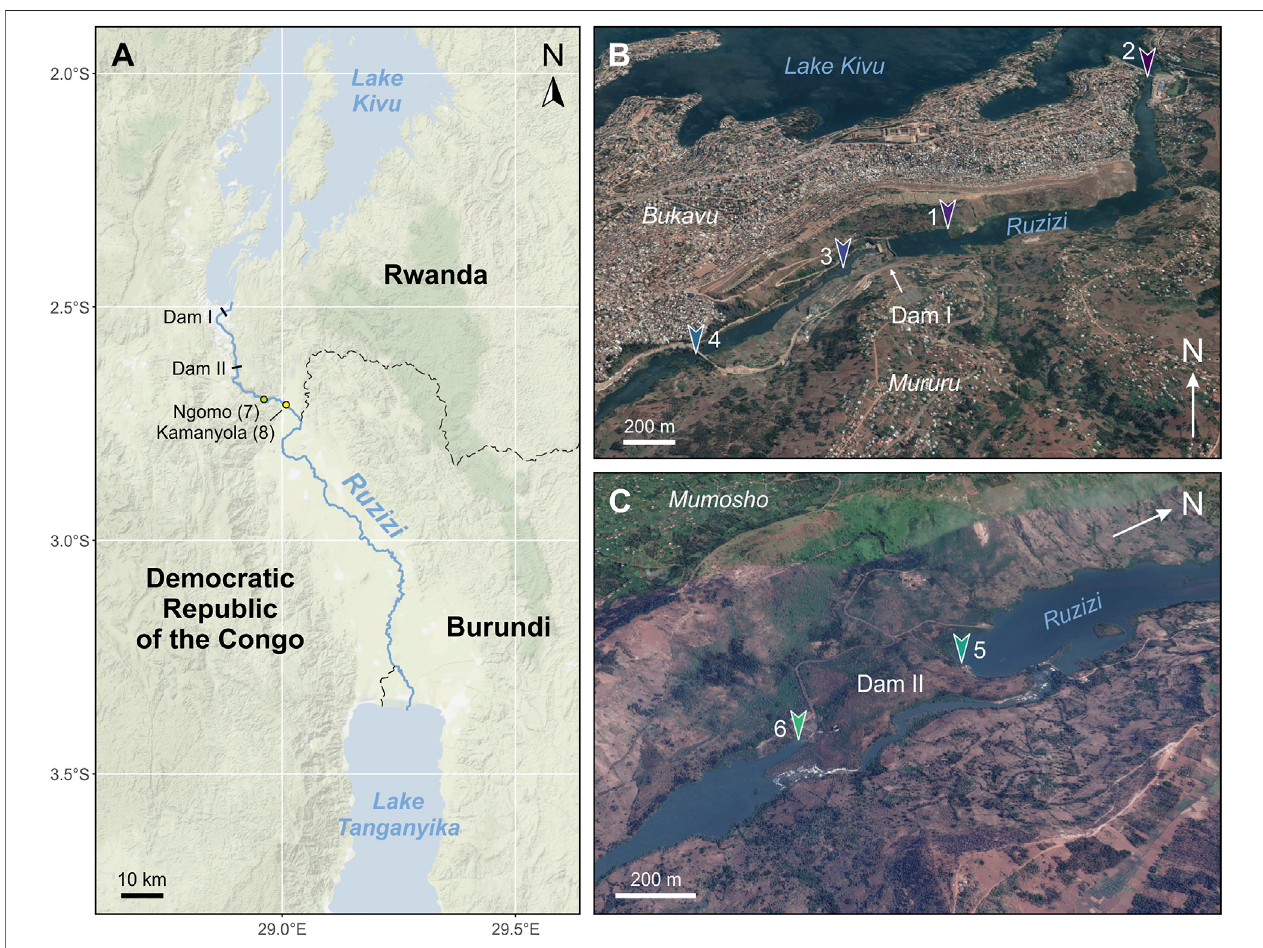
FIGURE1| Location ofthe Ruzizi River, the dams, and collecting sites. See Table1 fordetailed information onthelocalities. (A) Ruzizi Riverwith DamIand Dam II andfurtherdownstreamsites. (B,C) SamplingsitelocationsdownstreamandupstreamofDamI(betweenMururuandBukavu)andDamII(inMumosho).Themapin (A) was created with the R package ggmap 3.0.0 (Kahle et al., 2019). (B, C) were created in Google Earth Pro 7.3.4.8248, map data © 2022 Google/Maxar Technologies.